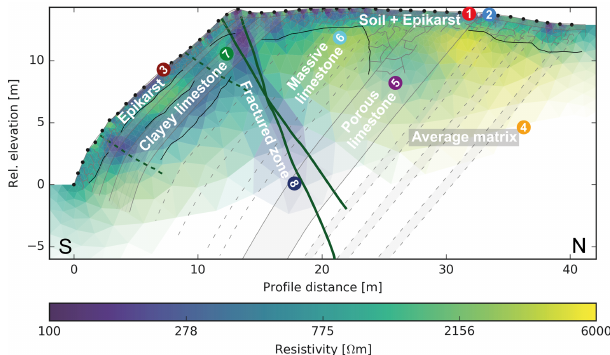
Figure 10. Superposition of the geological model from Fig. 2 on ERT results from March 2017, highlighting the interpretation of the resistivity distribution and anomalies. Numbers of the resistivity clusters defined in Fig. 7 are added for